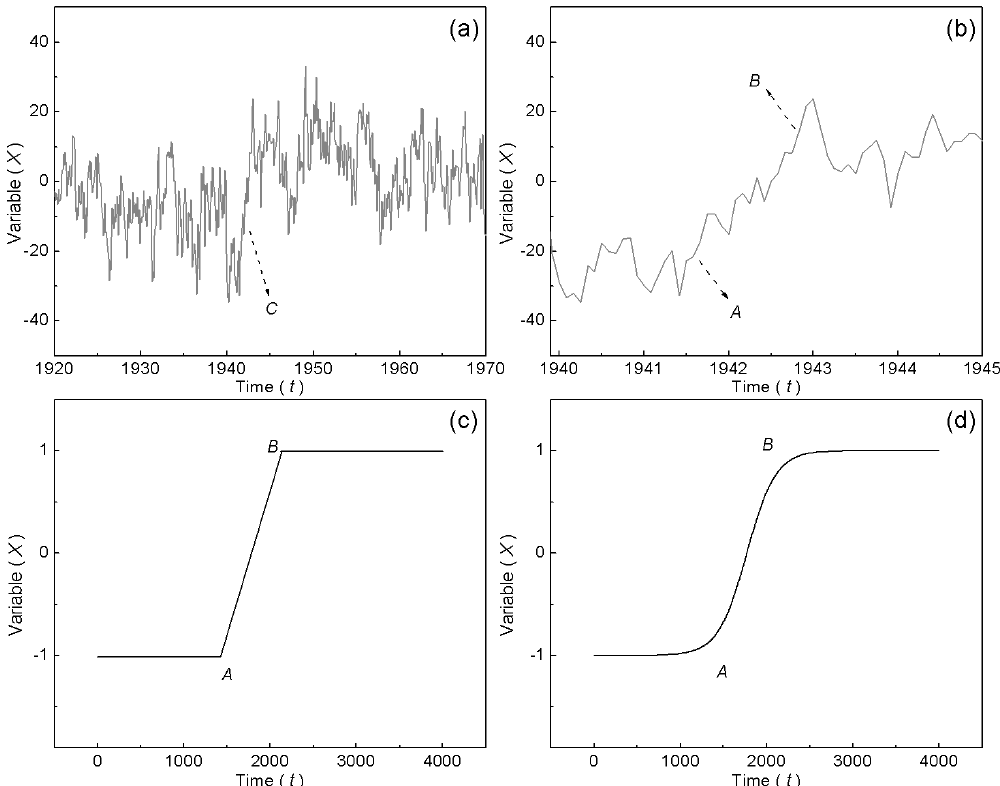
Figure 1. Transition process of abrupt change in a real time sequence and an ideal time sequence. (a) The Pacific Decadal Oscillation (PDO) time sequence during 1920–1970. (b) The PDO time sequence during 1940–1945. (c) The transition process presented by piece-wise function. (d) The transition process presented by continuous function. Table 1. The parameters of ideal models.